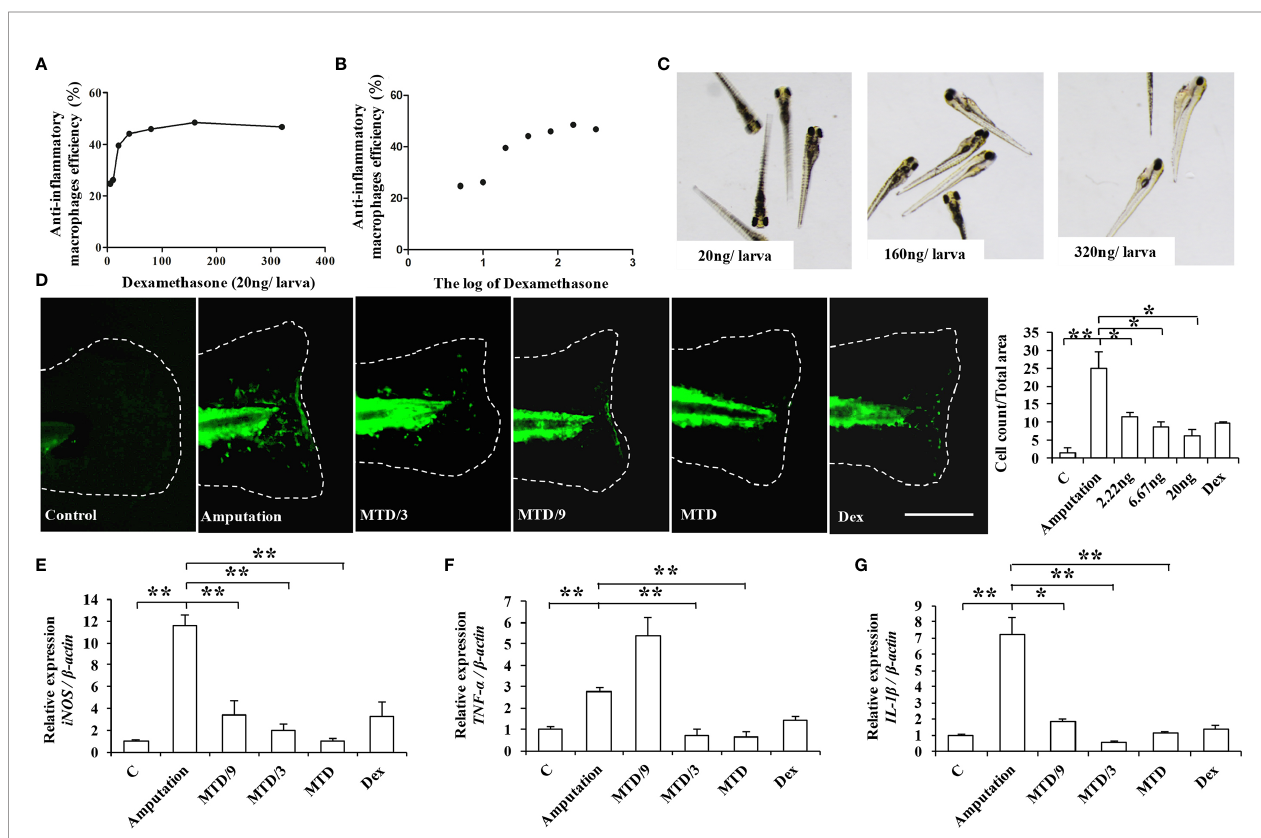
FIGURE 9 | LA inhibits the recruitment of macrophages to the in fl ammation site and inhibits the secretion of local in fl ammatory factors at the early stage of in fl ammation in the caudal fi n resection model in zebra fi sh larvae (A, B) Graphs showing the effects of Dex. The 20 ng/larva injection dose of Dex shows a signi fi cant anti-in fl ammatory effect, with anti-in fl ammatory effects on macrophages up to 40% (P < 0.05). (C) The 20 ng/larva injection dose of Dex had no effect on the physiological state of zebra fi sh, while the higher injection doses caused a loss of balance and even pericardial edema. (D) Macrophages were recruited to the wounds in amputated larvae at 24 hpA, while an injection of LA signi fi cantly inhibited the cell count of macrophages in the wound tissues, which was most signi fi cantly shown in the MTD group (20.0 ng/larva) (n=10). (E) Real-time PCR results show that an LA injection inhibited the expression levels of iNOS in wound tissues, and 20.0 ng/larva LA downregulated the expression level of iNOS more than the other doses (n=3). (F) 20.0 ng/larva LA decreased the expression of TNF- a in the wound tissues, which was not signi fi cantly different compared with the positive control group Dex (n=3). (G) LA also signi fi cantly decreased the expression of IL-1 b , with an inhibitory effect stronger than that of Dex (n=3). Scale bar in (D) = 100 m m. Results are expressed as means ± standard deviation (SD), and statistical signi fi cance is shown as N P > 0.05, *P < 0.05, **P <